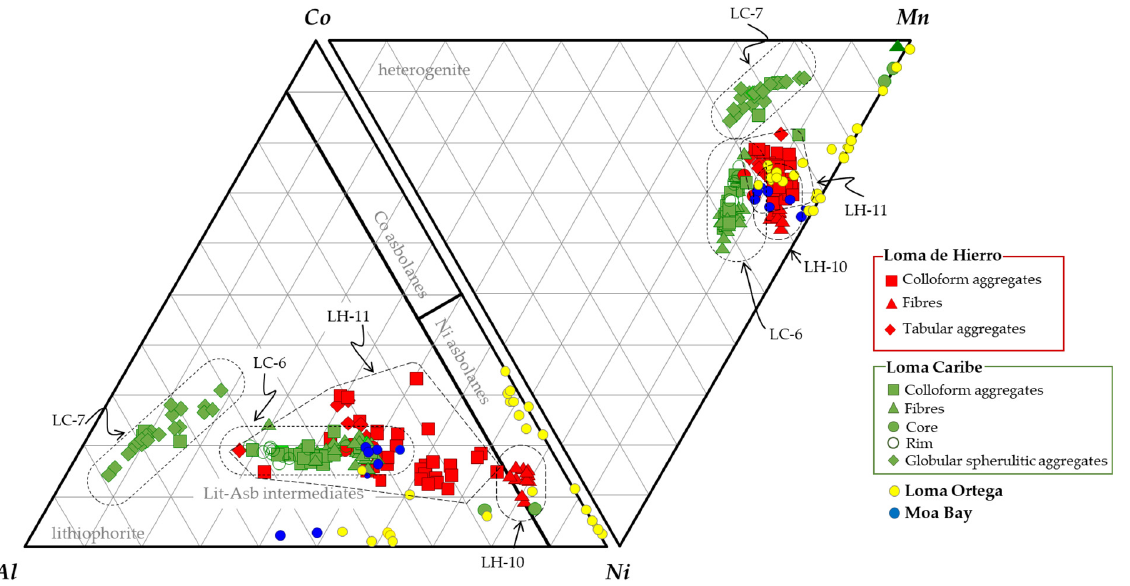
Figure 13. Ternary plots representing Mn, Ni, Co, Al contents (cation proportions calculated on the basis of 100 oxygens) obtained from EMPA analyses on Mn-oxyhydroxides (lithiophorites, lithiophorite–asbolane intermediates and asbolane) from Loma Caribe and Loma de Hierro (this study), Loma Ortega [46] and Moa Bay